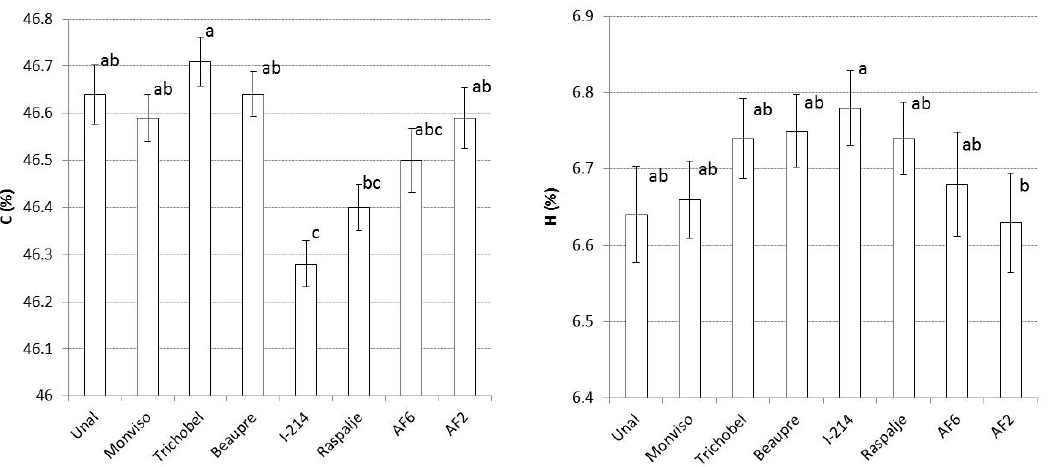
Figure 6. Mean values (and standard errors) of the C ( left ) and H ( right ) concentrations (%) for the eight poplar genotypes tested. Different letters denote significant differences (Tukey test).